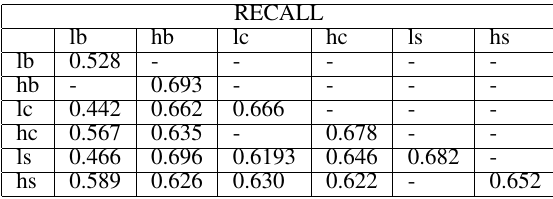
Table 7. Recall values in when using altered